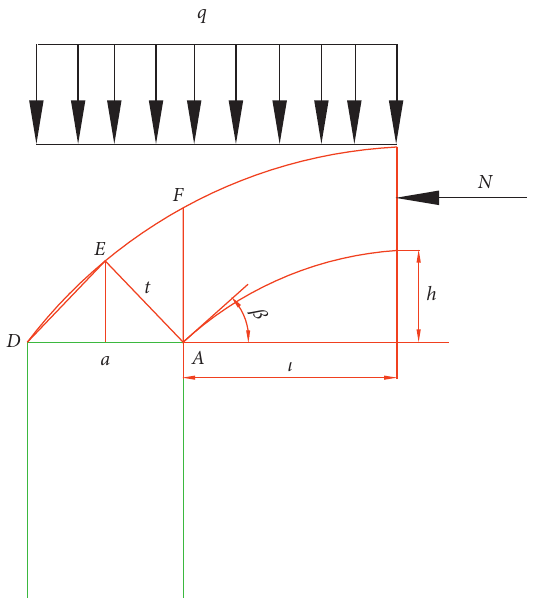
Figure 5: Pile-back soil arch force